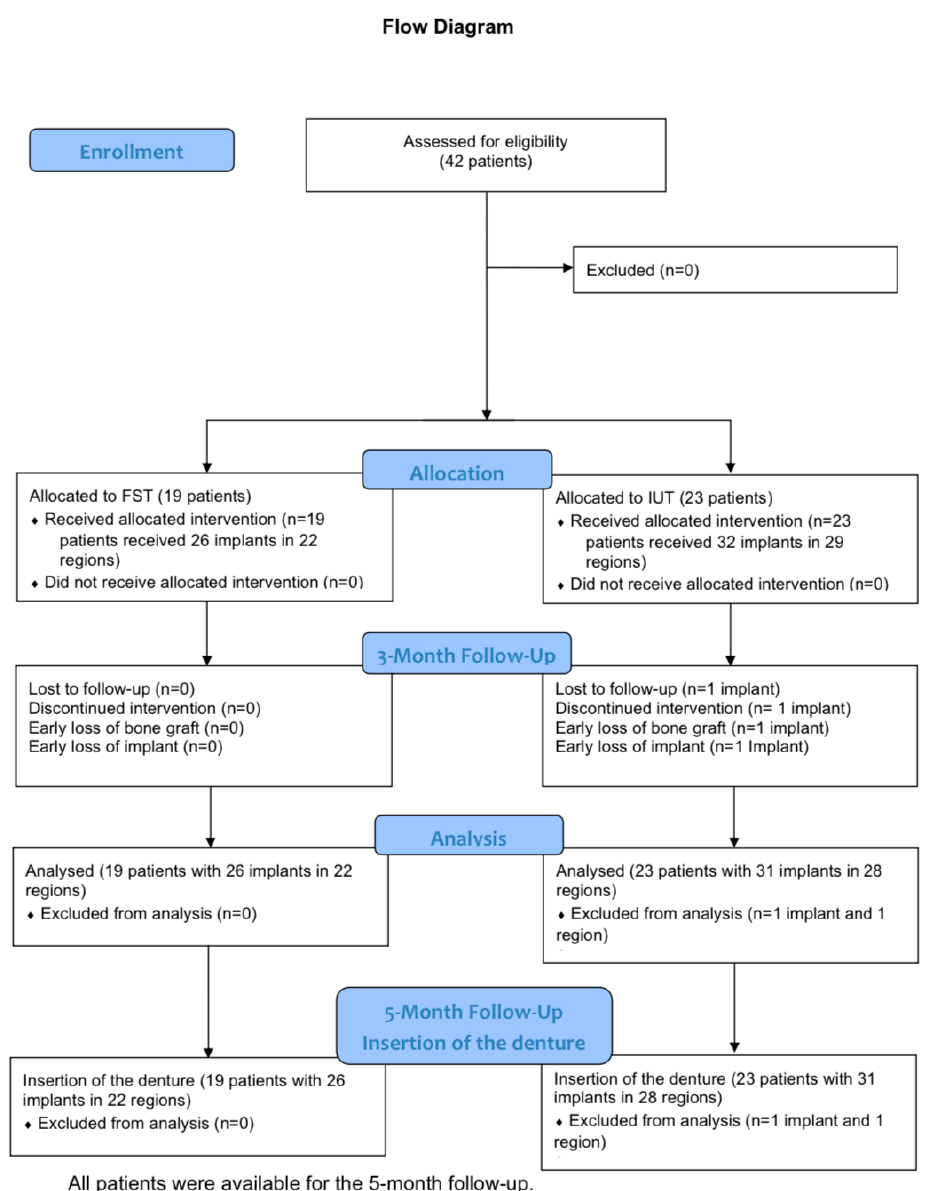
Figure 5. CONSORT flow diagram. The follow-up is reduced in the IUT group in the 3-month follow-up by the implant/augmentation with the severe complication. The patient was further examined due to another implant/augmentation in another jaw region. In the 5-month follow-up, all dentures were inserted.